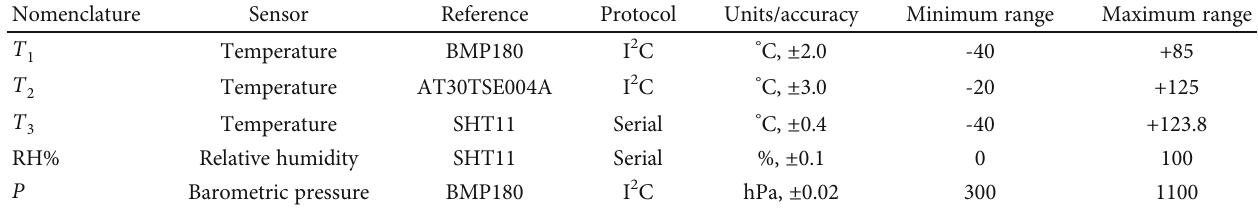
Table 1: Sensor datasheet corresponding to some dependent variables or response variables.